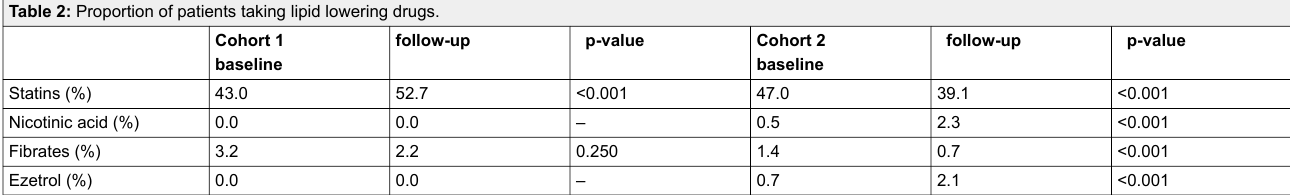
Table 2: Proportion of patients taking lipid lowering